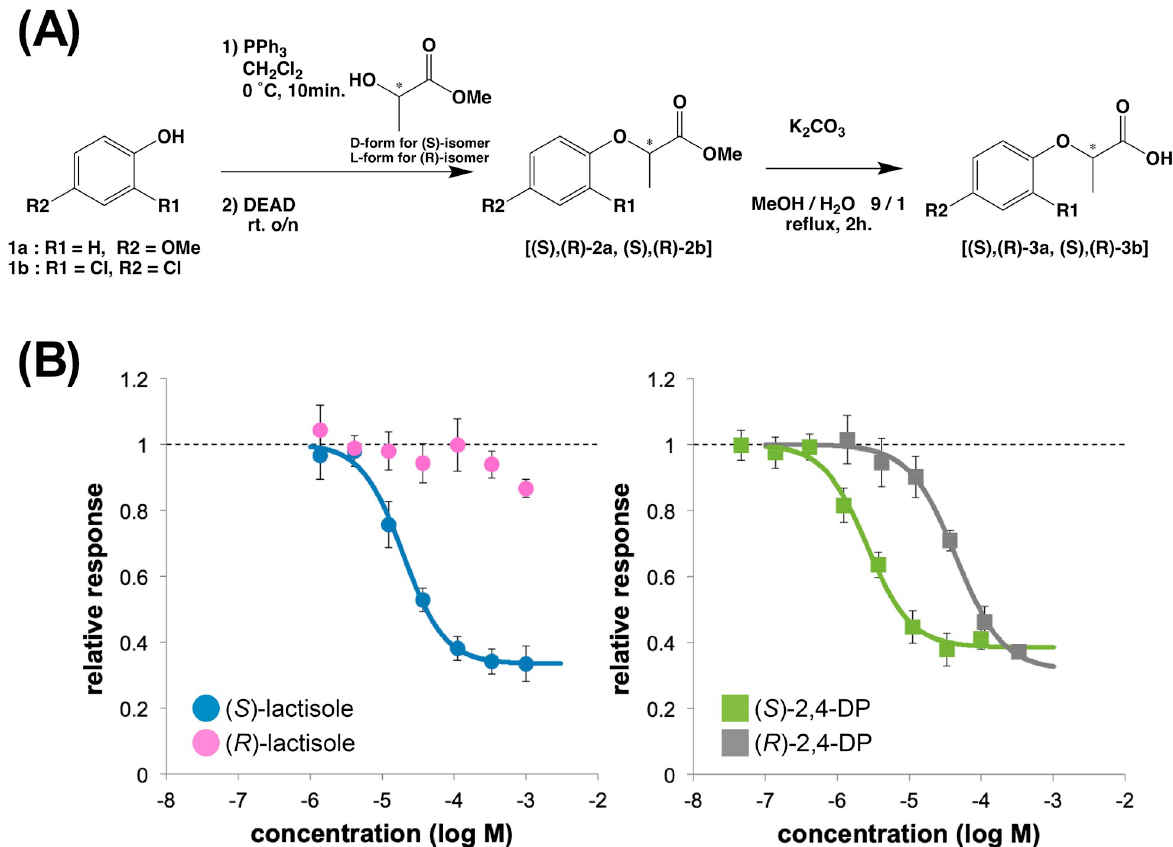
Fig 4. Sweet taste inhibitory activity of ( S )-, ( R )-lactisole and ( S )-, ( R )-2,4-DP. (A) Flow chart of the synthesis of each isomer of lactisole and 2,4-DP. (B) Cellular response to 1 mM aspartame plus the indicated concentration of each compound against the cells expressing the WT sweet taste receptor. The left panel shows the results for the lactisole isomers: ( S )-lactisole (blue) and ( R )-lactisole (pink). The right panel shows the results for the 2,4-DP isomers: ( S )-2,4-DP (green), and ( R )-2,4-DP (gray). Data are shown as the mean ± SEM (n = 4).